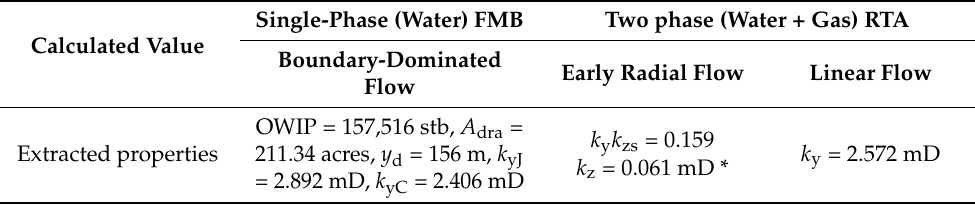
Table 6. Extracted properties of the field example.